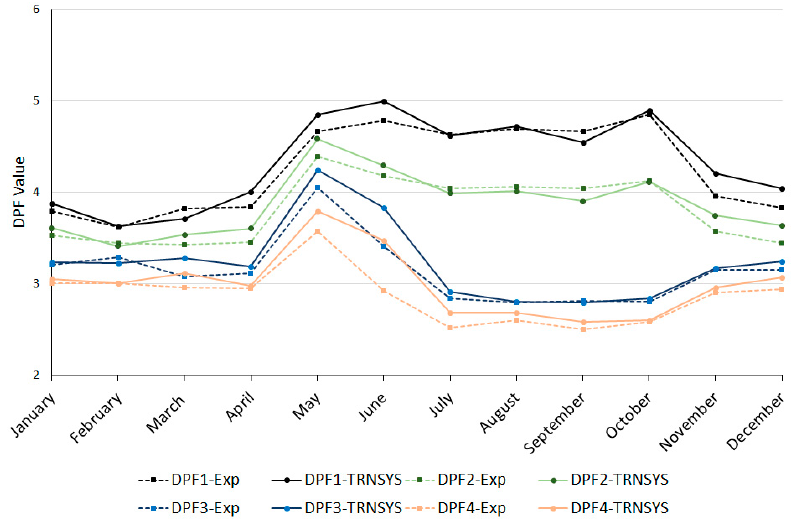
Figure 13. DPF simulation results (monthly average).